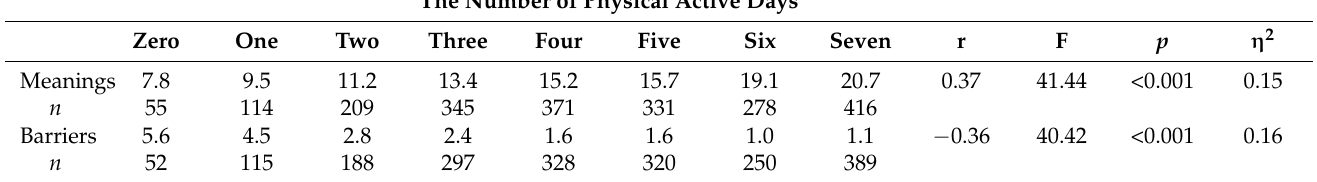
Table 3. The average number of meanings (important or very important, max 34) and barriers (holds true at least somewhat, max 18) by the number of physically active days (zero to seven) in the past week (at least 60 min per day) (Pearson correlation coefficients r, and general linear model (ANCOVA) adjusted for gender and BMI (F, p , η 2